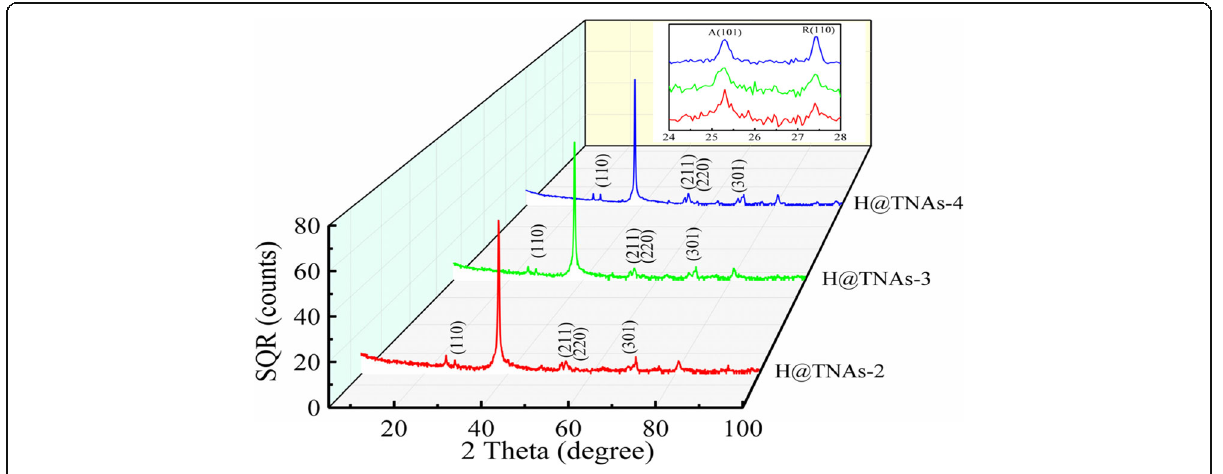
Fig. 8 XRD patterns of H@TNAs-2, H@TNAs-3 and H@TNAs-4. Inset is the enlargement of the range from 24 to 28°